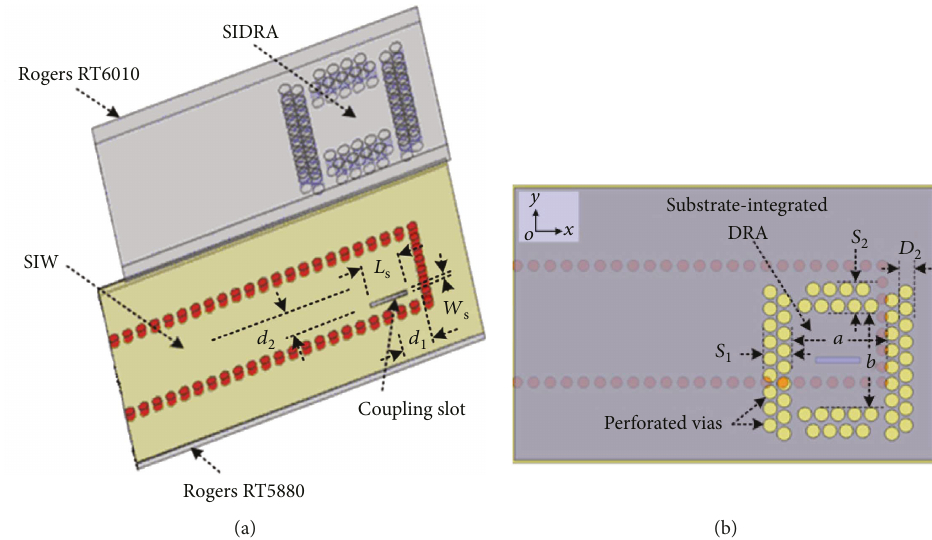
Figure 1: Structure of the SIDRA element with the longitudinal coupling slot. (a) 3D view and (b) top view. ( L =0.55, all in d 2